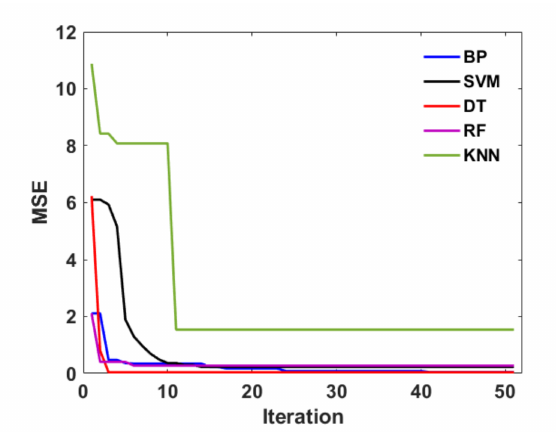
Figure 6. MSE versus iteration for five individual ML algorithms.